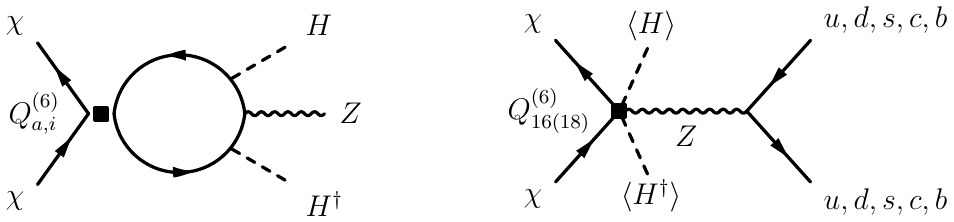
operators into the a;i